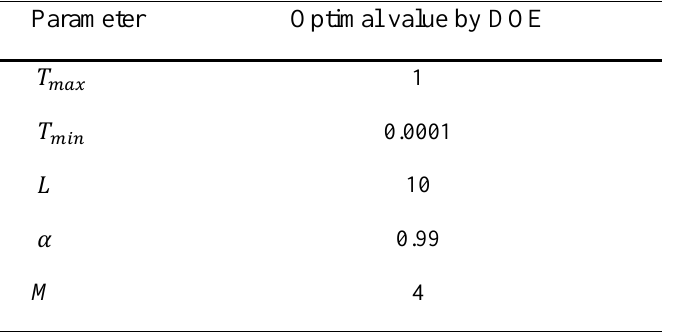
Table 7. A comparison between the results of the current work and previous papers in EA-CSLP case study.